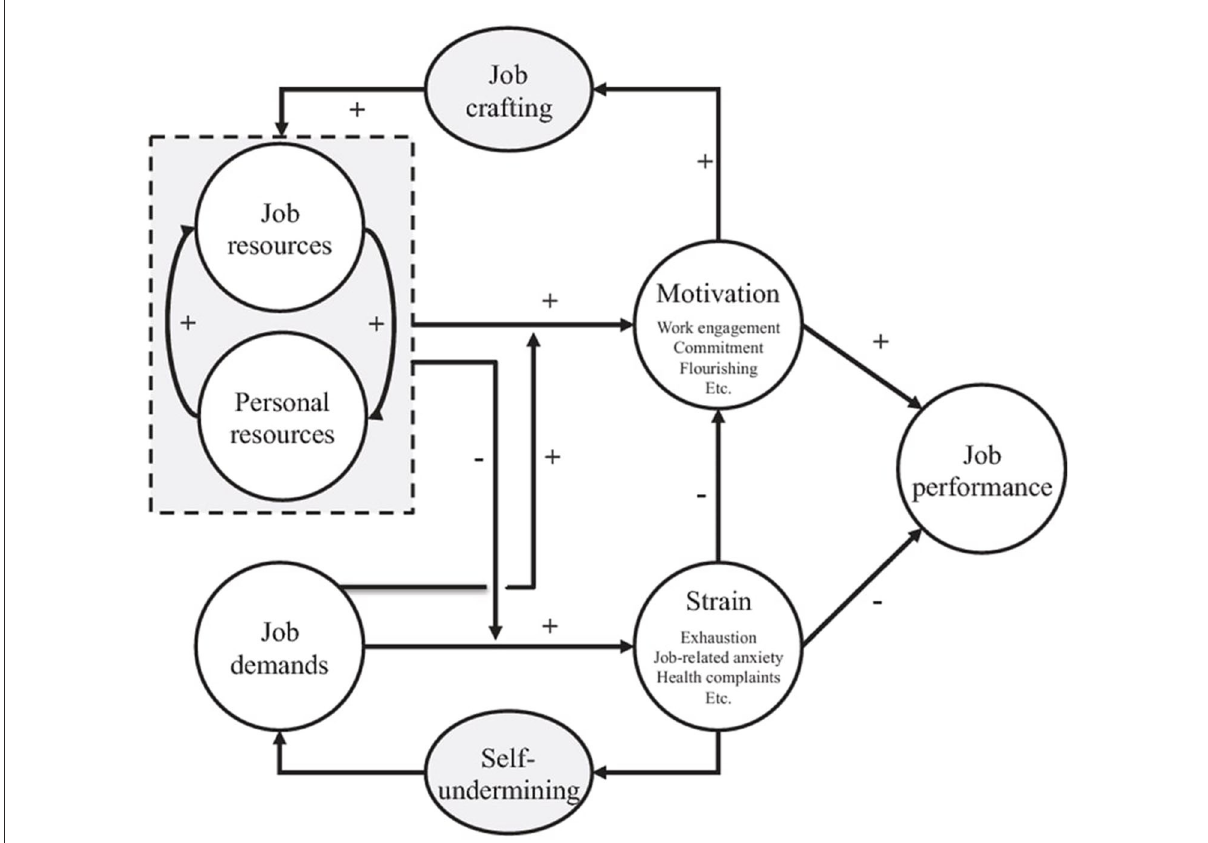
FIGURE1 The job demands-resources (JD-R) model, adapted from Bakker and Demerouti